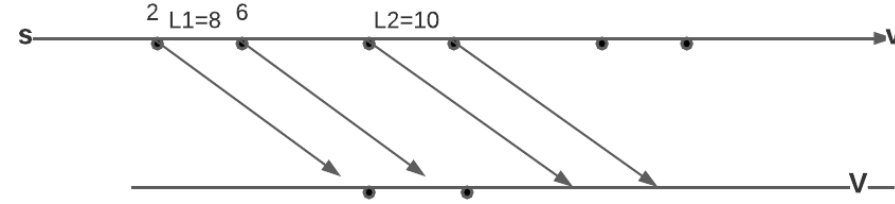
Figure 10. Example of a walk